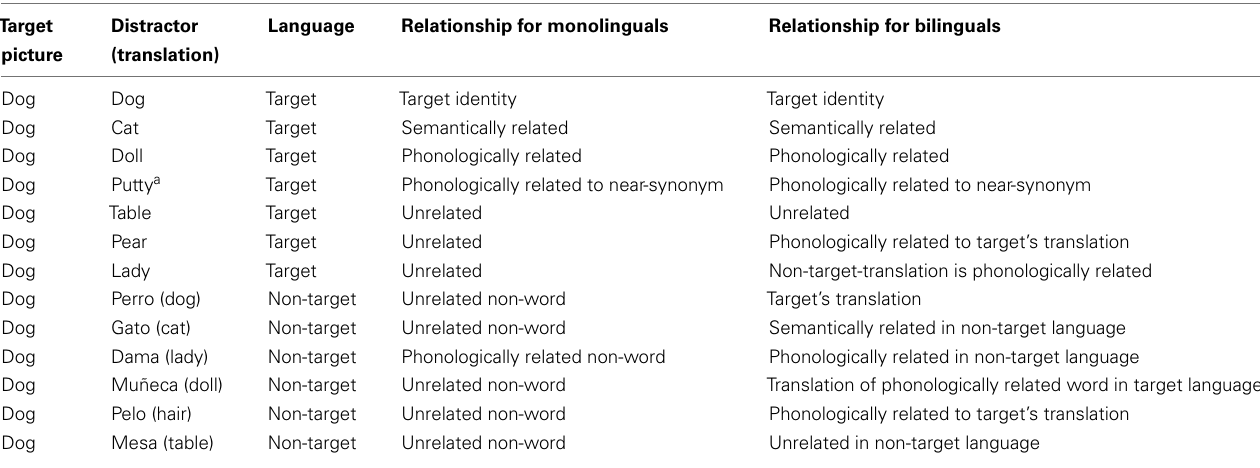
Table 1 | Example distractors and their relationship to the target for monolinguals and